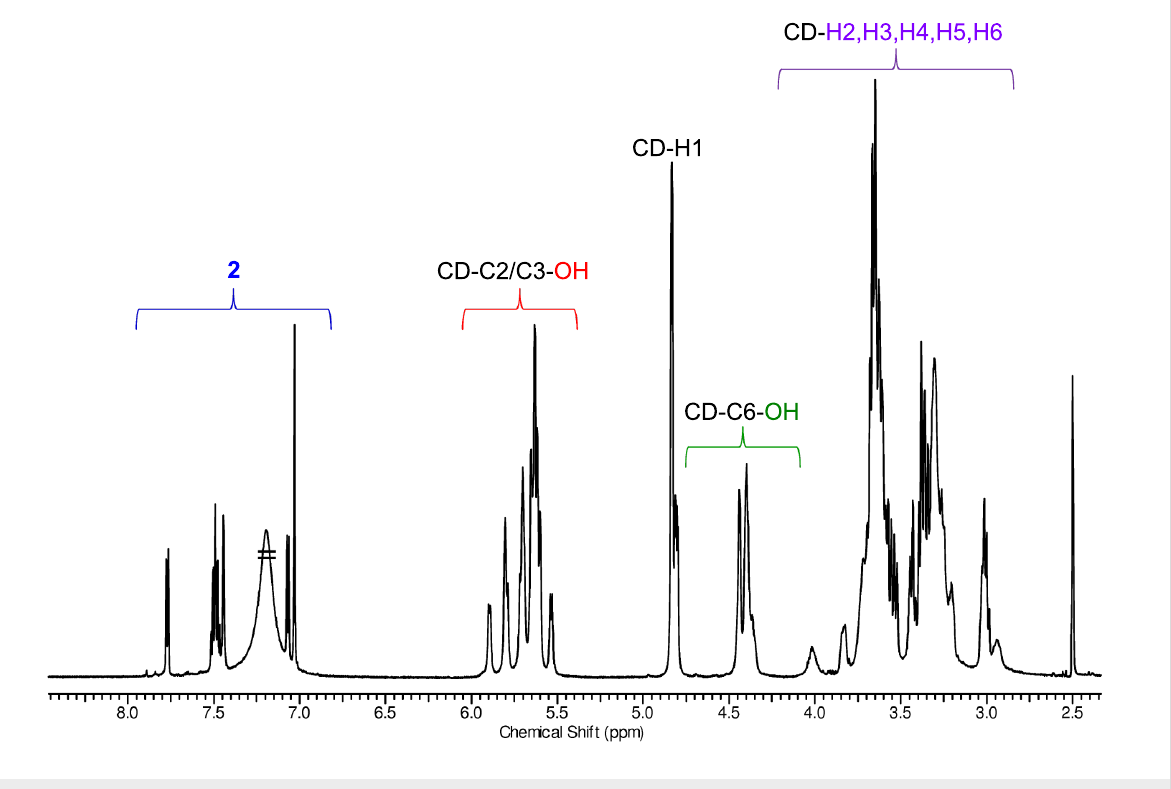
Figure 4: 1 H NMR spectrum of 2 – β -CD with partial assignment (DMSO- d 6 , 600 MHz, 298 K).